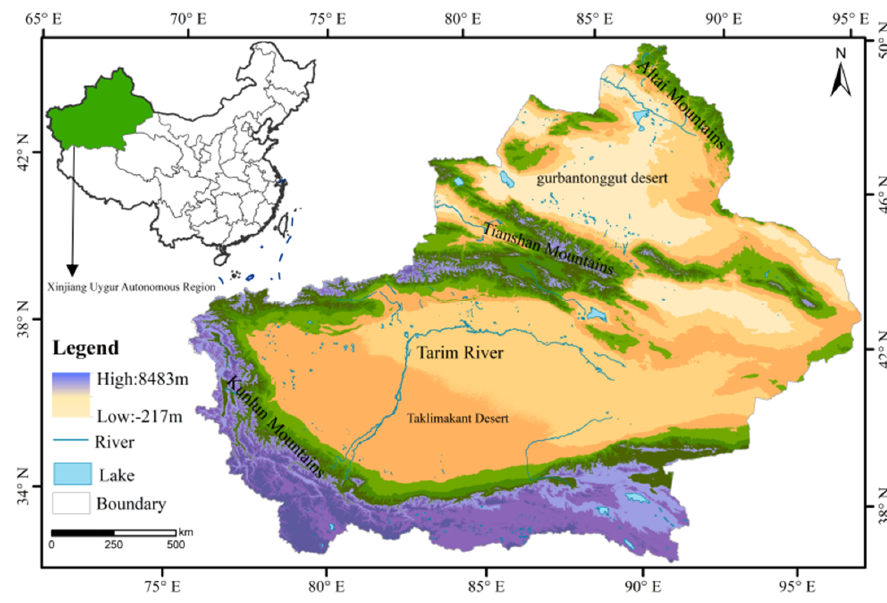
Figure 1. Sketch map of the study area.